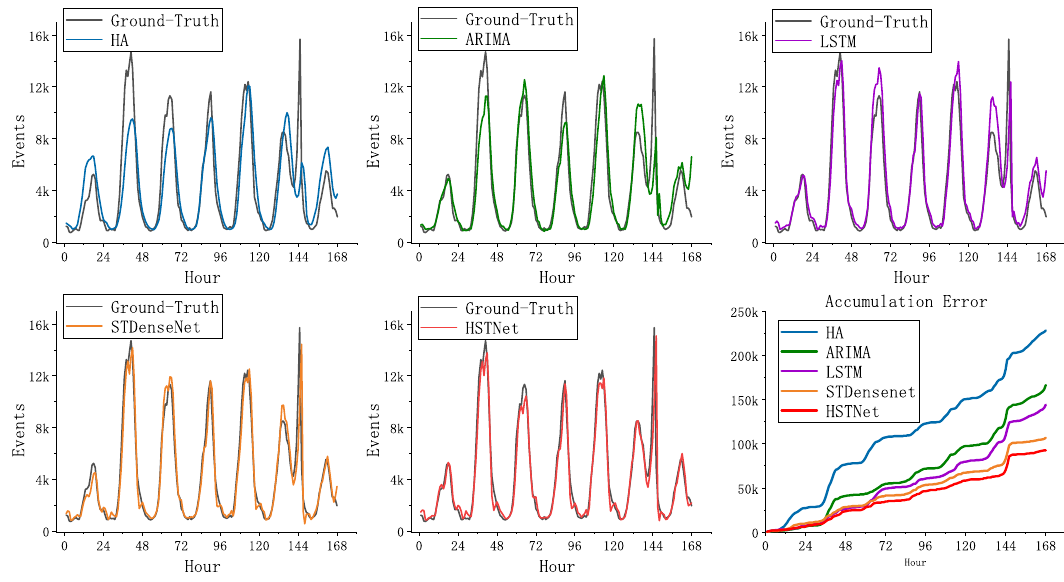
Figure 10. Comparison of the baseline and HSTNet on cell